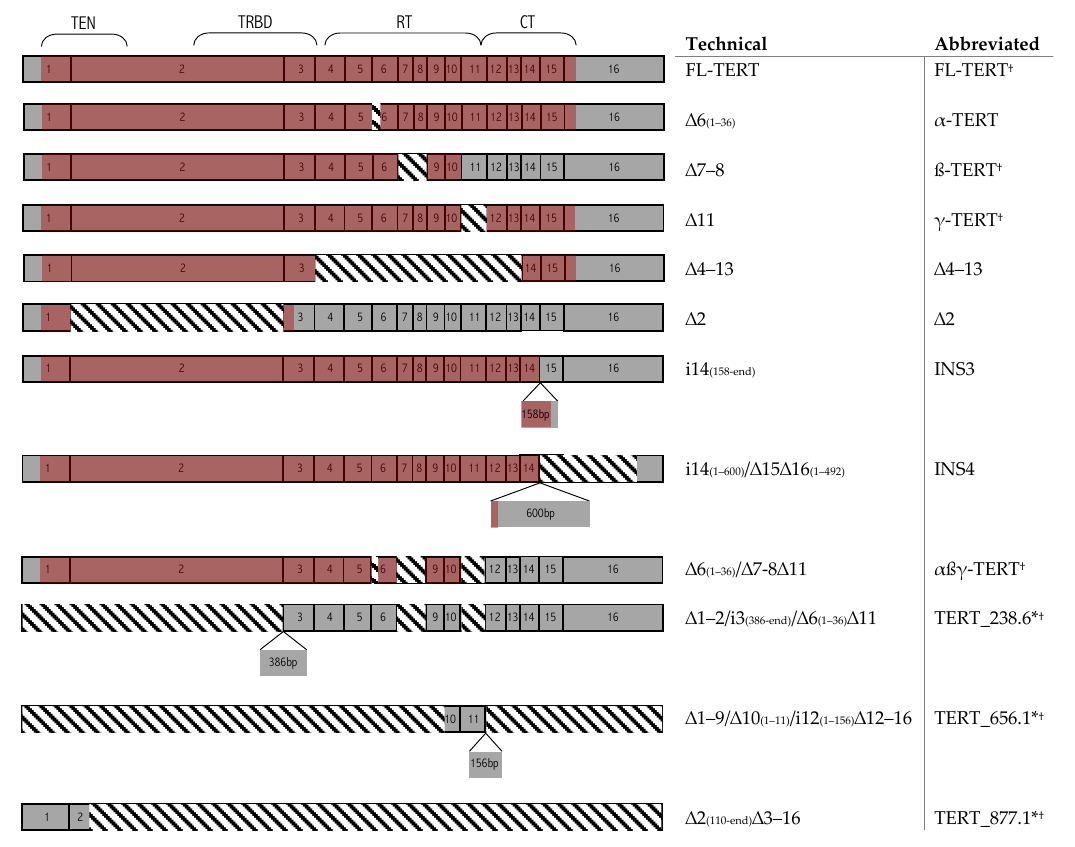
Figure 1. mRNA structure of commonly investigated TERT isoforms and those annotated in Ensembl Build 93. Full- length (FL)TERT consists of 16 exons that make up four domains: TEN, TRBD, RT, and CT. Splicing can involve deletions, which are marked with downward diagonal stripes; or insertions, which are marked with smaller boxes indicating insertional size and an arrowhead indicating the insertional point. ORFs are shown with a light red shade layered over the mRNA structure. Technical isoform name terminology includes “ ∆ ” representing deletions and “i” representing insertions. * Abbreviated names are taken from Ensembl transcript ID (TERT_238.6—ENST00000484238.6; TERT_656.1— ENST00000503656.1; TERT_877.1—ENST00000522877.1). † Indicates transcripts annotated in Ensembl Build 93. All Ensembl transcripts are either automatically generated from the Ensembl genebuild pipeline or manually annotated by human and vertebrate analysis and annotation (HAVANA), supported by transcriptional evidence either from complementary DNA, expressed sequence tags, or protein sequences. Telomerase essential N-terminal domain (TEN); Telomerase RNA binding domain (TRBD); C-terminal extension domain (CT); Central catalytic reverse transcriptase domain (RT); Open-reading frame